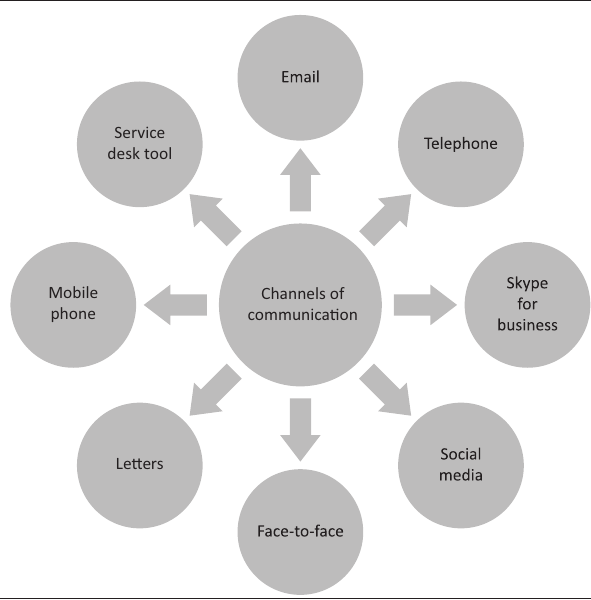
FIGURE 5: Communication channels utilised for collaborations in Namibia context.